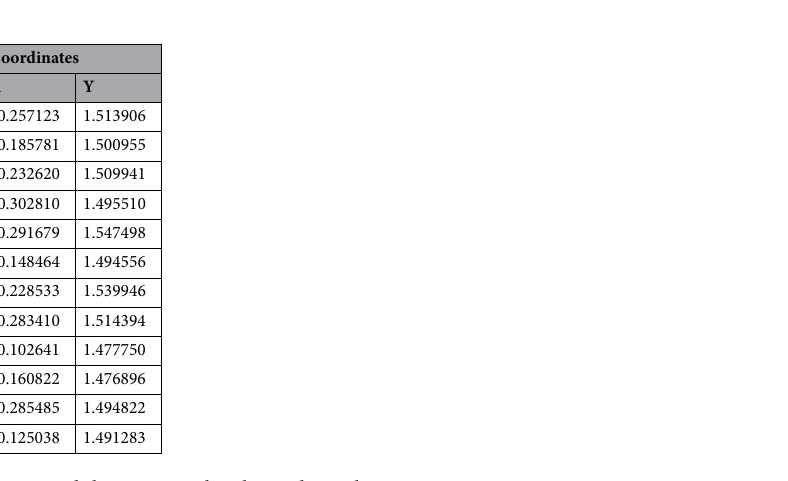
Table 1. The sampling sites and their geographical coordinate